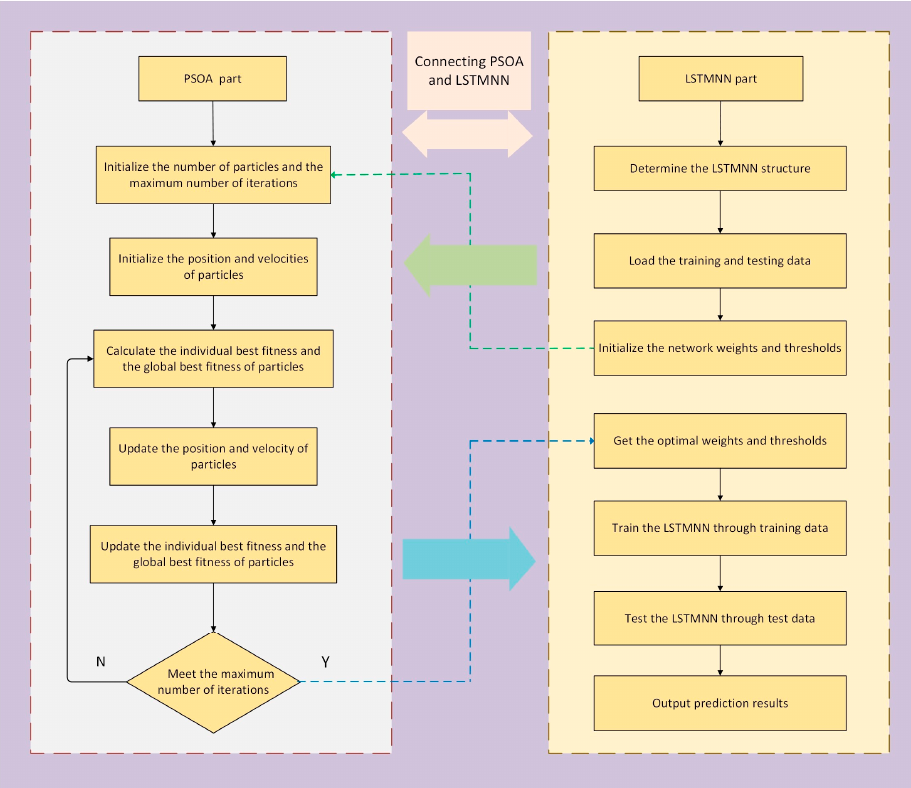
Figure 4. PSOA-LSTMNN modeling process